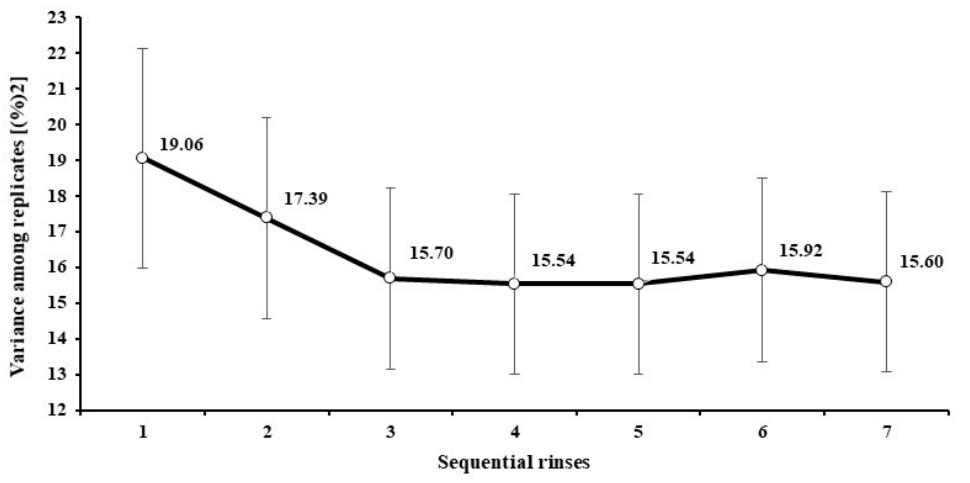
Figure 3. Estimates of variances among replicates ( ± standard error) for the apparently undigested residue, according to the number of rinses after in vitro incubation.